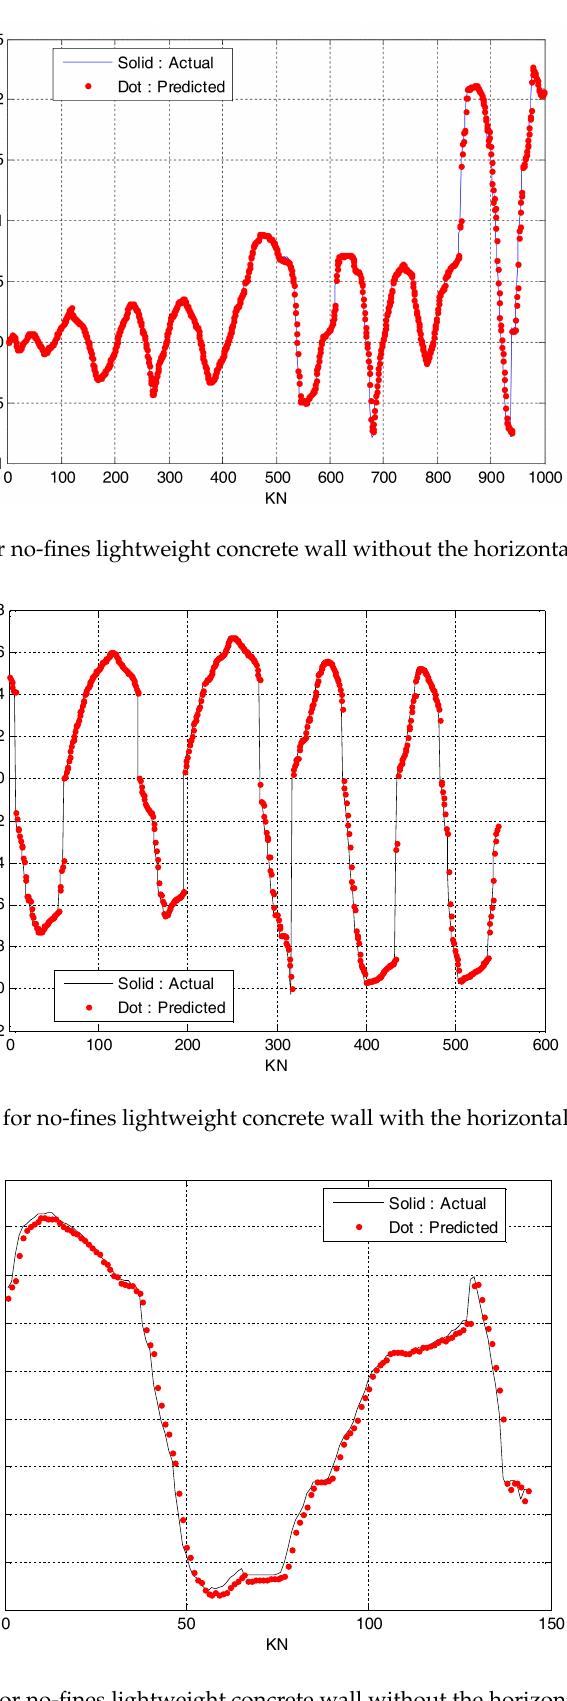
Figure 10. Validation for no-fines lightweight concrete wall without the horizontal reinforcement.